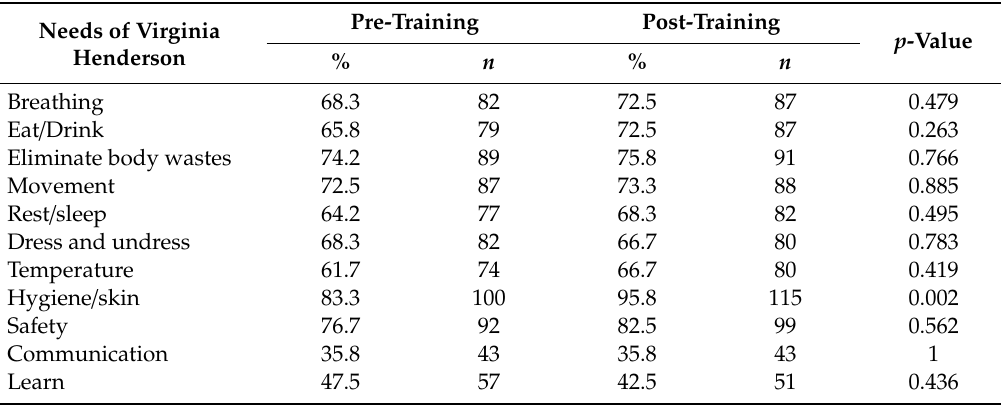
Table 1. Completion of nursing